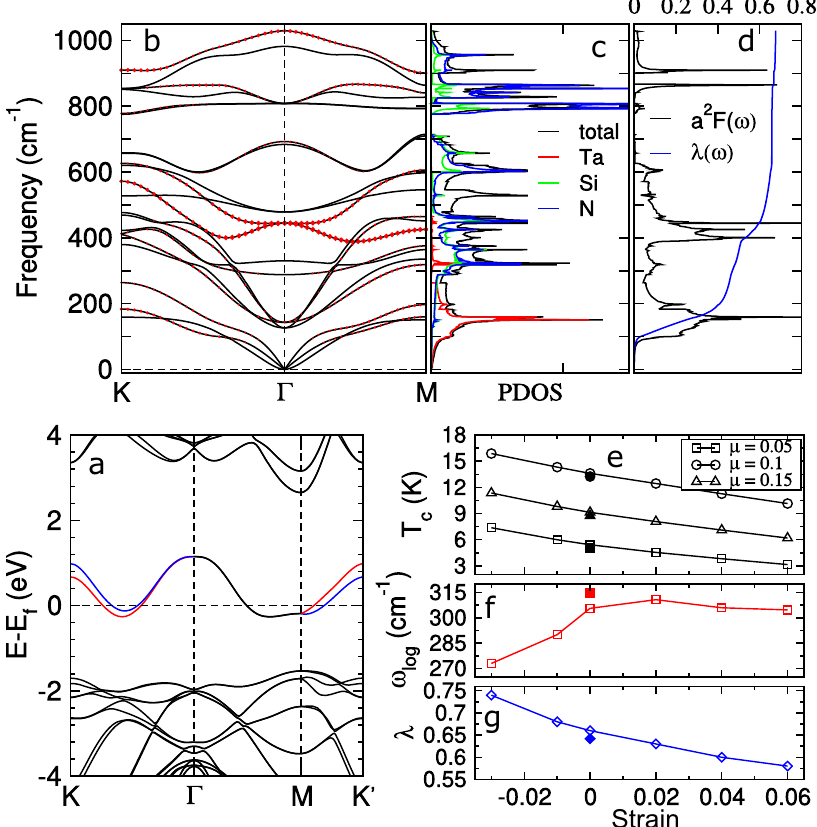
Fig. 5 Ising superconductivity in α 1 -TaSi 2 N 4 . a Contrasting spin splitting at K and K 0 for α 1 -TaSi 2 N 4 due to the SOC-induced Zeeman-like fi eld. The red and blue lines represent different spin states. b Phonon dispersions and c phonon density of states of α 1 -TaSi 2 N 4 . d Eliashberg function α 2 F ( ω ) and the electron – phonon coupling strength λ ( ω ). Strain dependence of e the superconducting transition temperature ( T c ), f logarithmic average phonon frequency ( ω log ), and g electron – phonon coupling constant ( λ ). The solid symbols at the 0% strain denote the SOC-containing